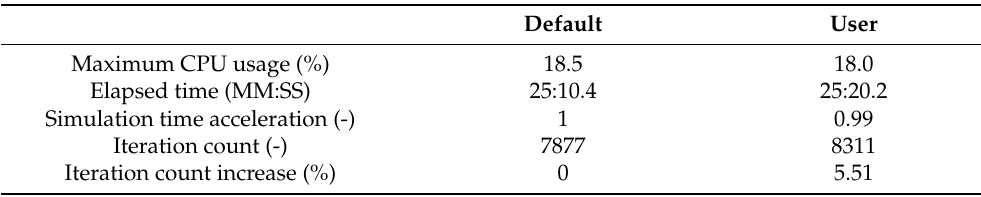
Table 1. Computational speed of the simulation using the Default and with the User method for a reduced number of mode shapes.